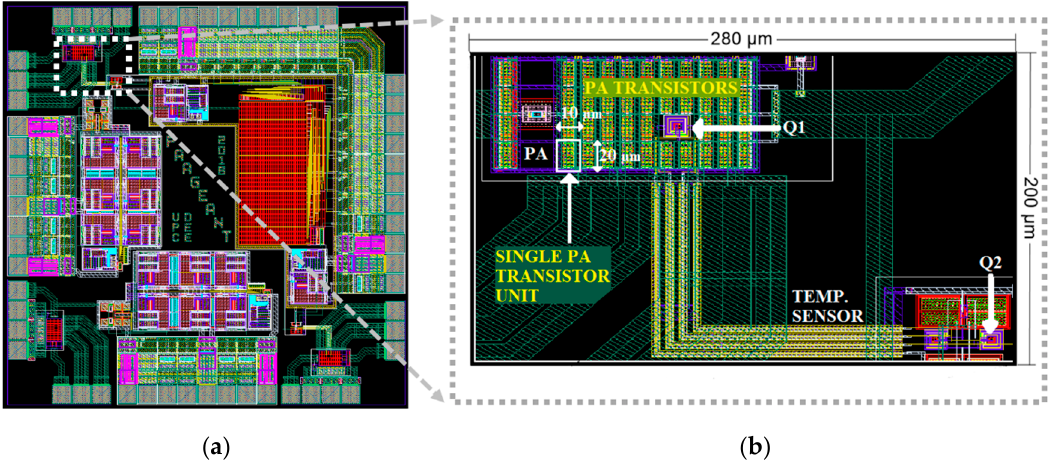
Figure 14. ( a ) Layout of the IC designed, containing several instances of the DUT + Temperature Sensor. ( b ) Detail of one of the power amplifiers and temperature sensor, highlighting the location of the temperature transducers Q1 and Q2.